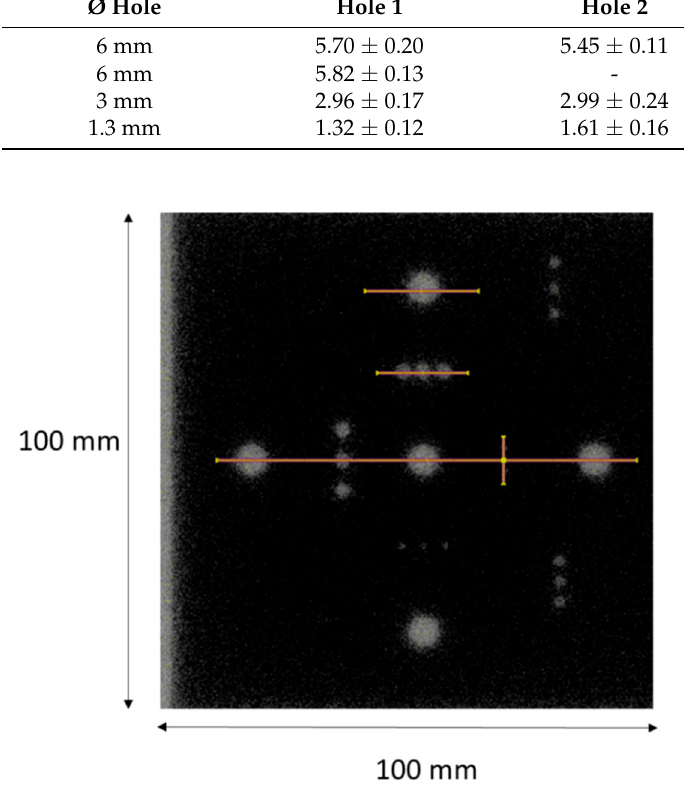
Figure 16. Image of the simulated energy deposition density in the drift gap. The solid yellow lines represent the selected regions for data analysis.